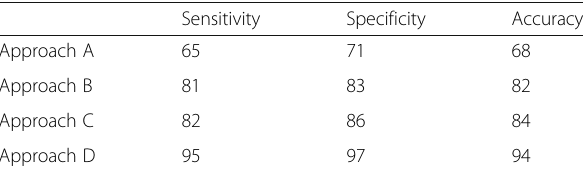
Table 3 Interobserver agreement for the diagnosis of complete ACL tear